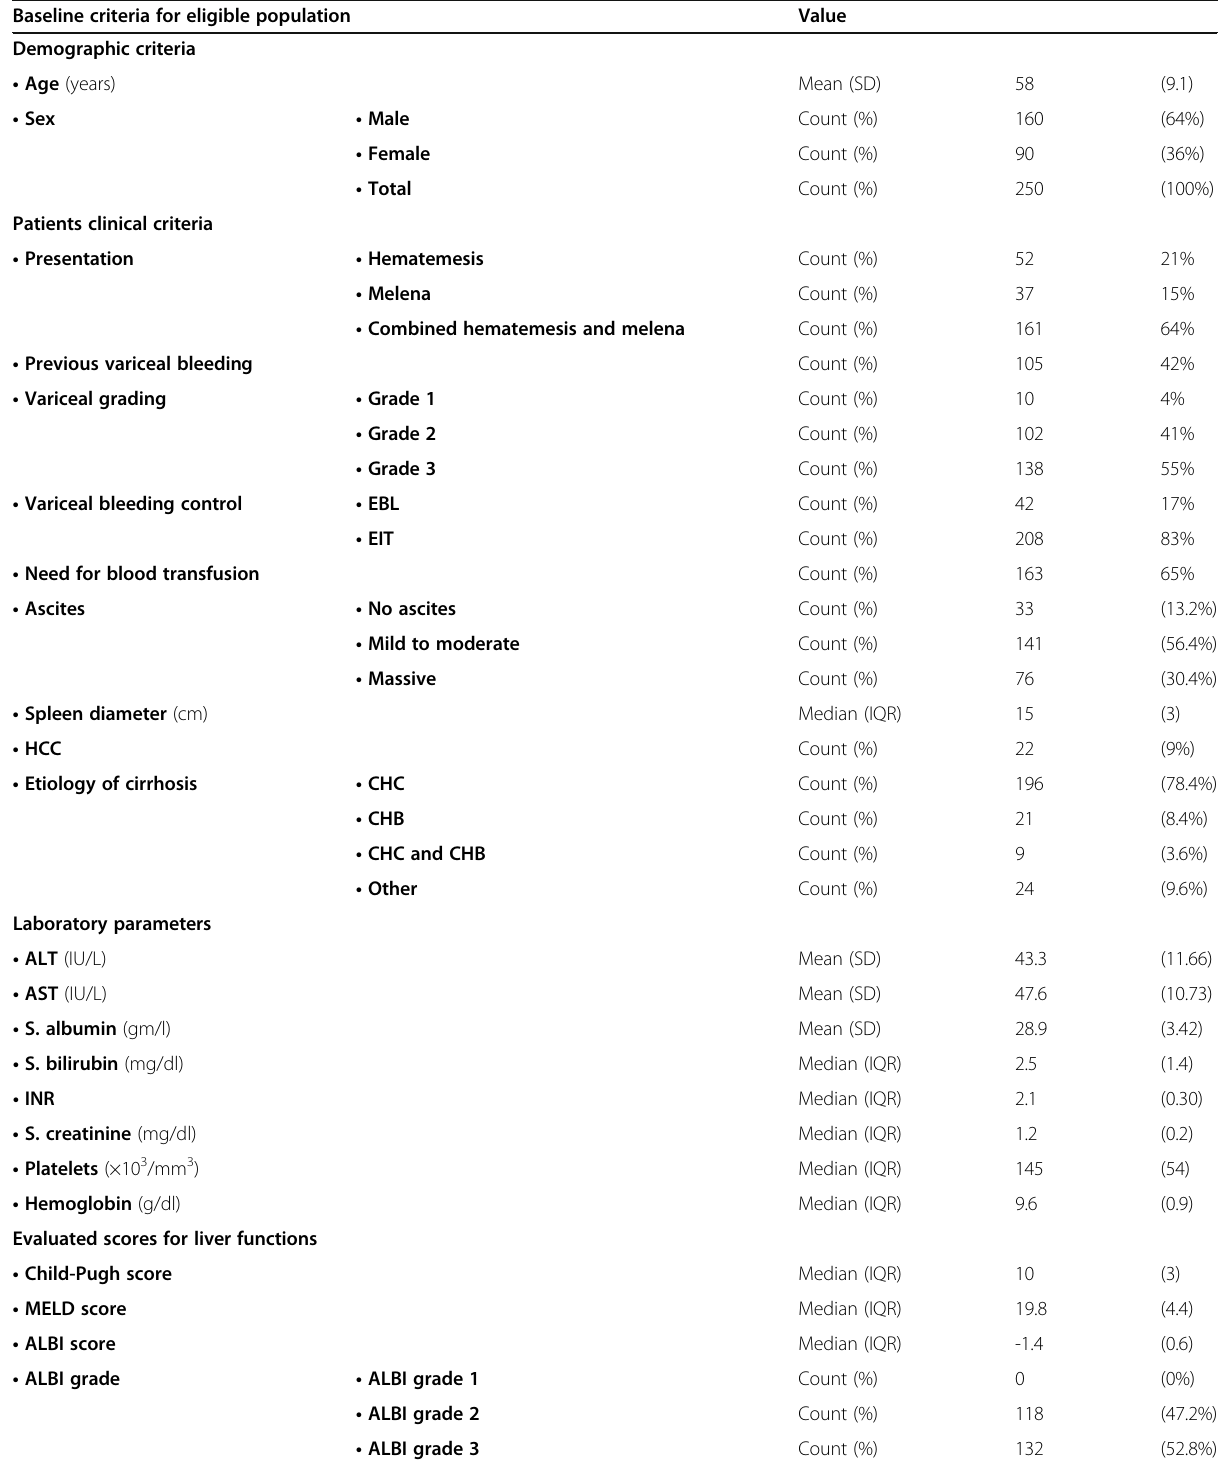
Table 1 Main baseline participants ’ criteria: Baseline criteria for eligible